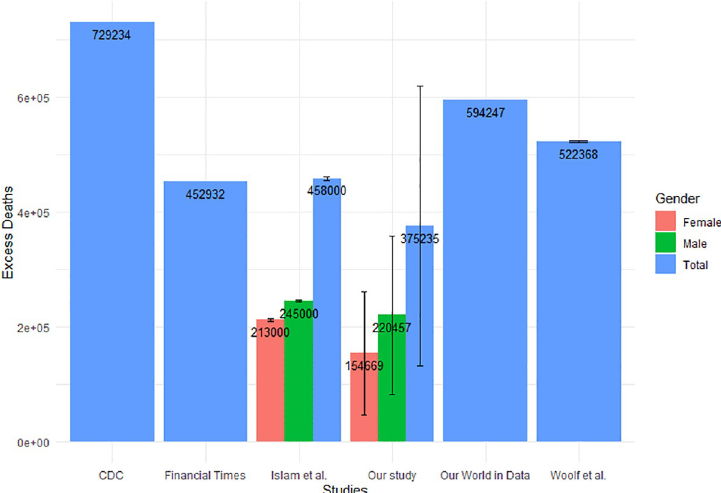
Fig 5. Comparison of excess mortality results attributable to COVID-19 pandemic in the United States in 2020 across different studies. Error bars are the uncertainty of how each effect impacted the excess mortality for each